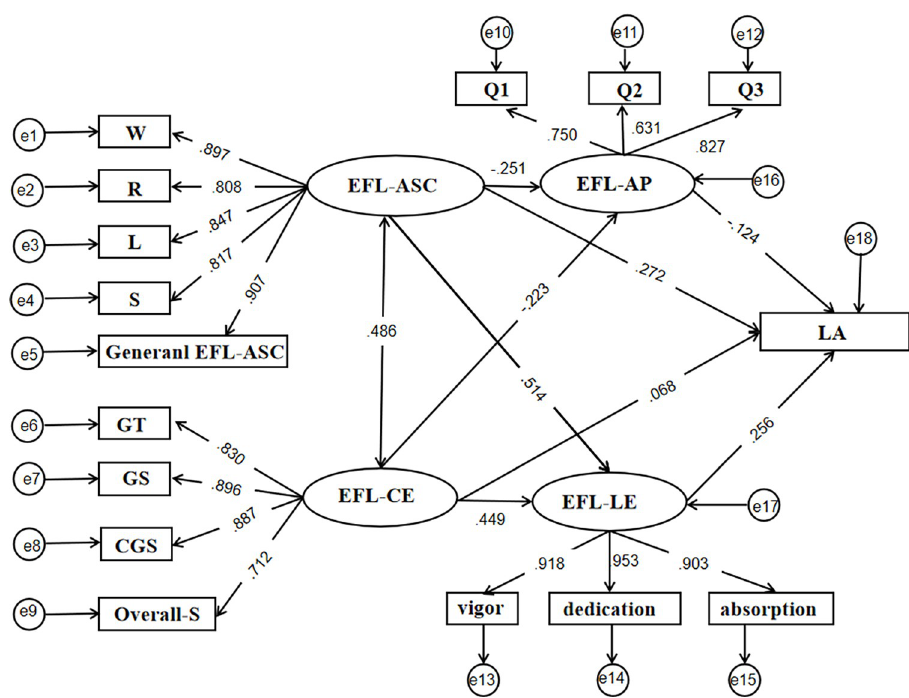
Fig 2. Mediation model effect plot. Note:W = Writing; R = Reading; L = Listening; S = Speaking; General EFL-ASC = General EFL Academic Self-Concept; GT = Good Teaching; GS = Generic Skills; CGS = Clear Goals and Standard; Overall-S = Overall Satisfaction; Q1 = Question 1; Q2 = Question 2; Q3 = Question 3; EFL-ASC = EFL-Academic Self-Concept; EFL-CE = EFL-Course Experience; EFL-AP = EFL-Academic Procrastination; EFL-LE = EFL-Learning Engagement; LA = Learning Achievement.